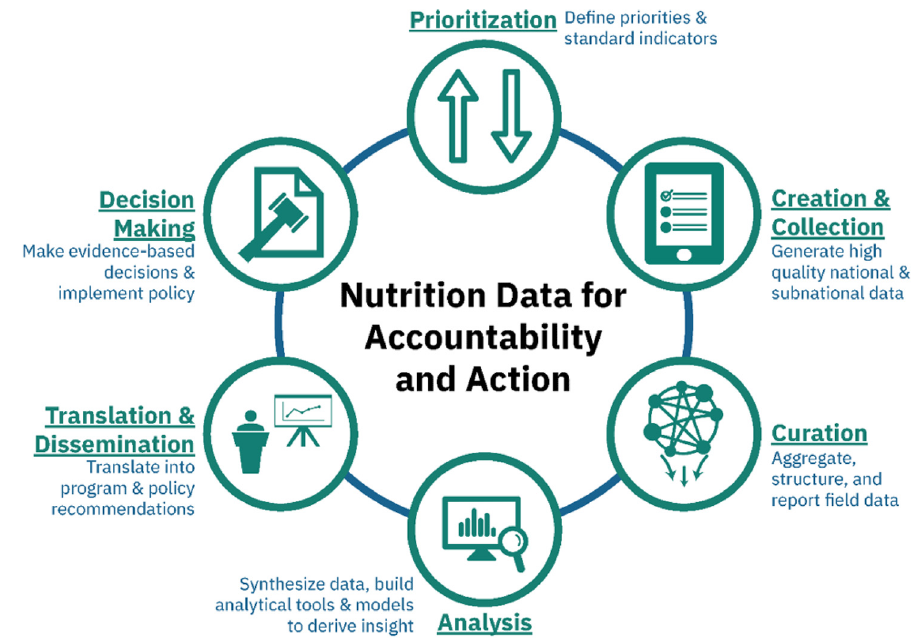
Figure 1. Nutrition data value chain. Adapted from Piwoz et al. , 2019 5